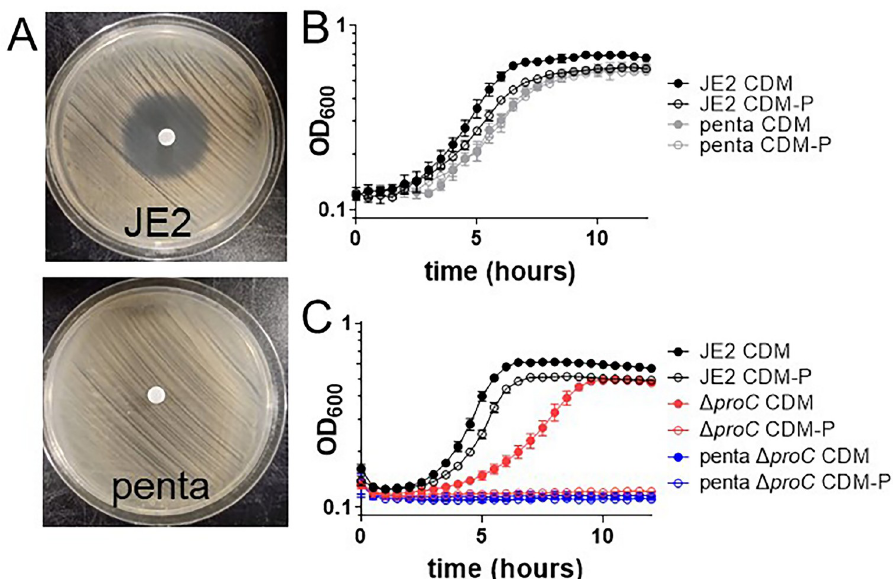
Fig 1. B7H15_03660 encodes an additional proline transporter. A) A large zone of inhibition surrounds the disc containing the toxic proline analog 3,4 dehydro-DL-proline (DHP). When all five putative transporters, including the newly identified B7H15_03660, are inactivated, the penta mutant is no longer susceptible to DHP. B) Growth analysis of JE2 and the penta mutant in CDM and CDM-P. C) Growth analysis of JE2, Δ proC , and penta Δ proC in CDM and CDM-P show an inability of the penta Δ proC mutant to grow in CDM. Data (B and C) are represented by the mean ± SD (n = 3).